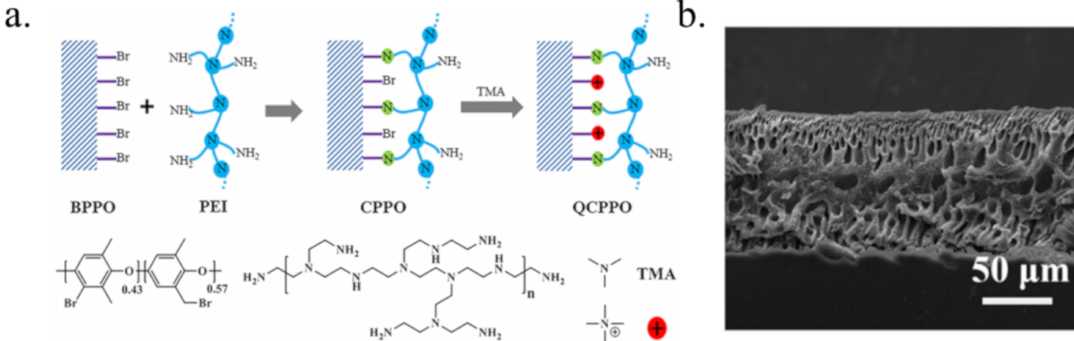
Figure 5. The preparation of the BPPO-based ultrafiltration membrane after modification and amination ( a ) and the cross section from SEM of the BPPO-based ultrafiltration membrane after modification and amination for 2 h ( b )